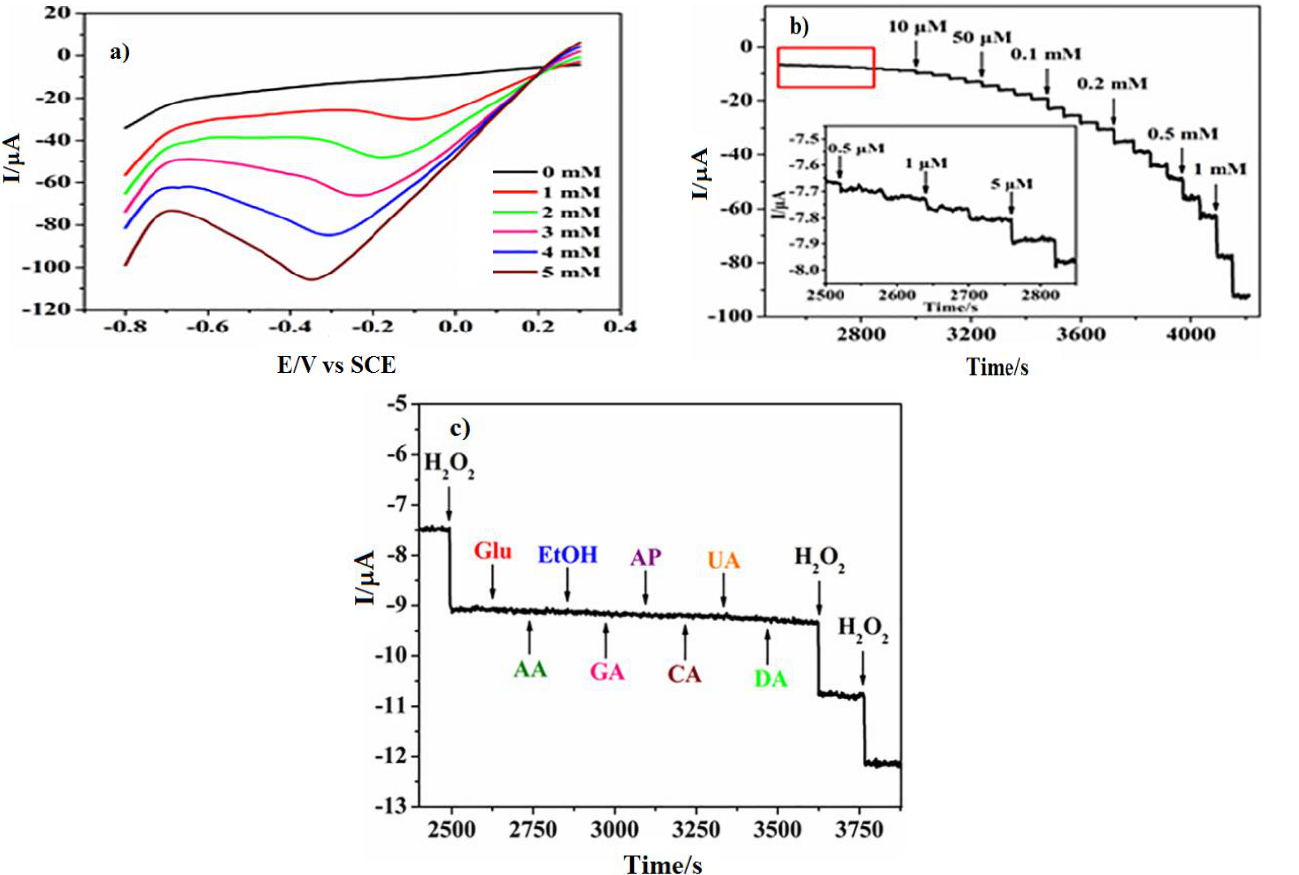
Figure 2. ( a ) Linear Sweep Voltammetry of the PtNi/NCNFs (3:1)-GCE electrode at different H 2 O 2 concentrations. ( a ) Current-time response of PtNi/NCNFs (3:1)-GCE to the successive additions of H 2 O 2 at − 0.1 V. ( b ) Amperometric response curve at PtNi/NCNFs (3:1)-GCE to successive additions of 0.1 mM H 2 O 2 and other electroactive species at − 0.1 V ( c ) in 0.2 M N 2 -saturated PBS. Adapted from Guan et al. [90], Copyright 2018 Elsevier.